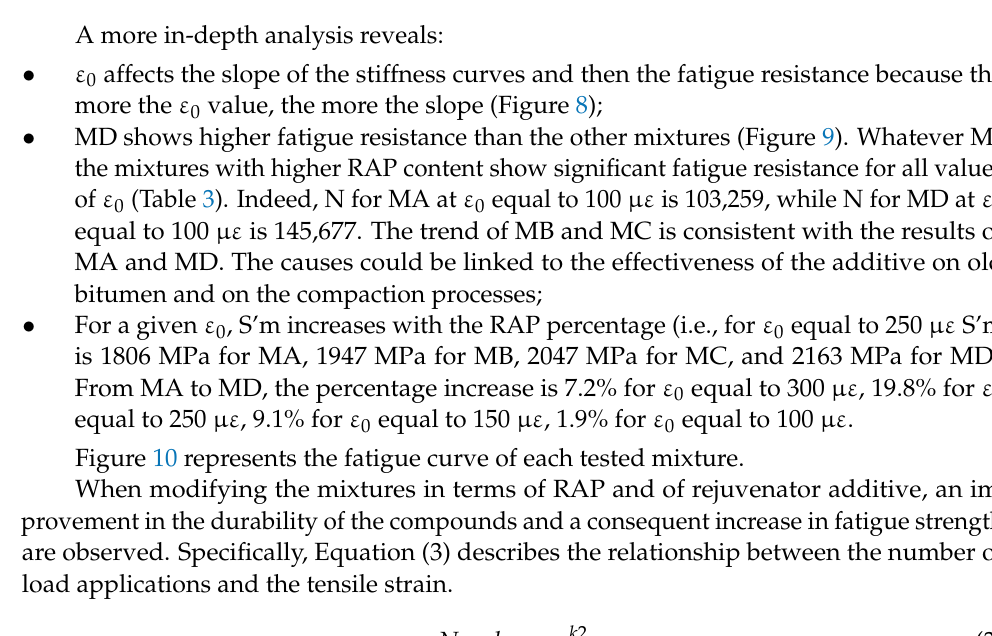
Figure 10. Mi4.25G fatigue curves. Table 3. Results of the fatigue tests. Mi